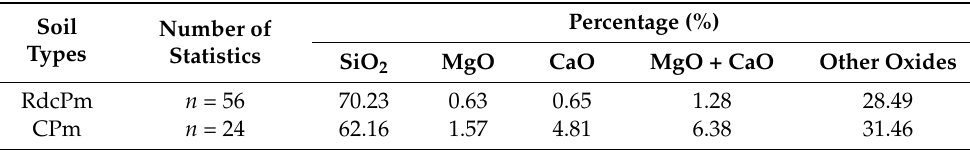
Table 2. Percentage contents of oxides in two soil parent materials.